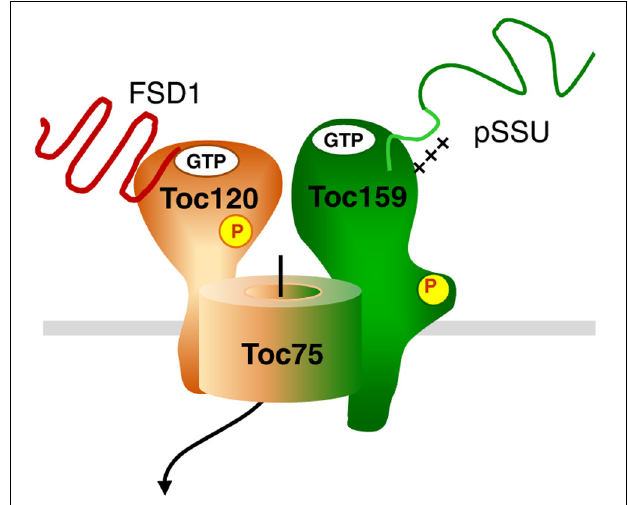
FIGURE 12 | Hypothetical model for dynamic TOC complexes. The general import pathway comprises Toc159, Toc34, and Toc75 as core components. The hypothetical translocon responsible for FSD1 import consists of Toc120, most likely Toc75 and unknown component(s). Green color indicates the pathway taken by canonical substrates, whereas orange signifies an alternative translocon. A mix of both colors indicates participation in both translocation machineries. Thus, Toc75 as the common channel can form a complex with both Toc120 and Toc159, but not necessarily at the same